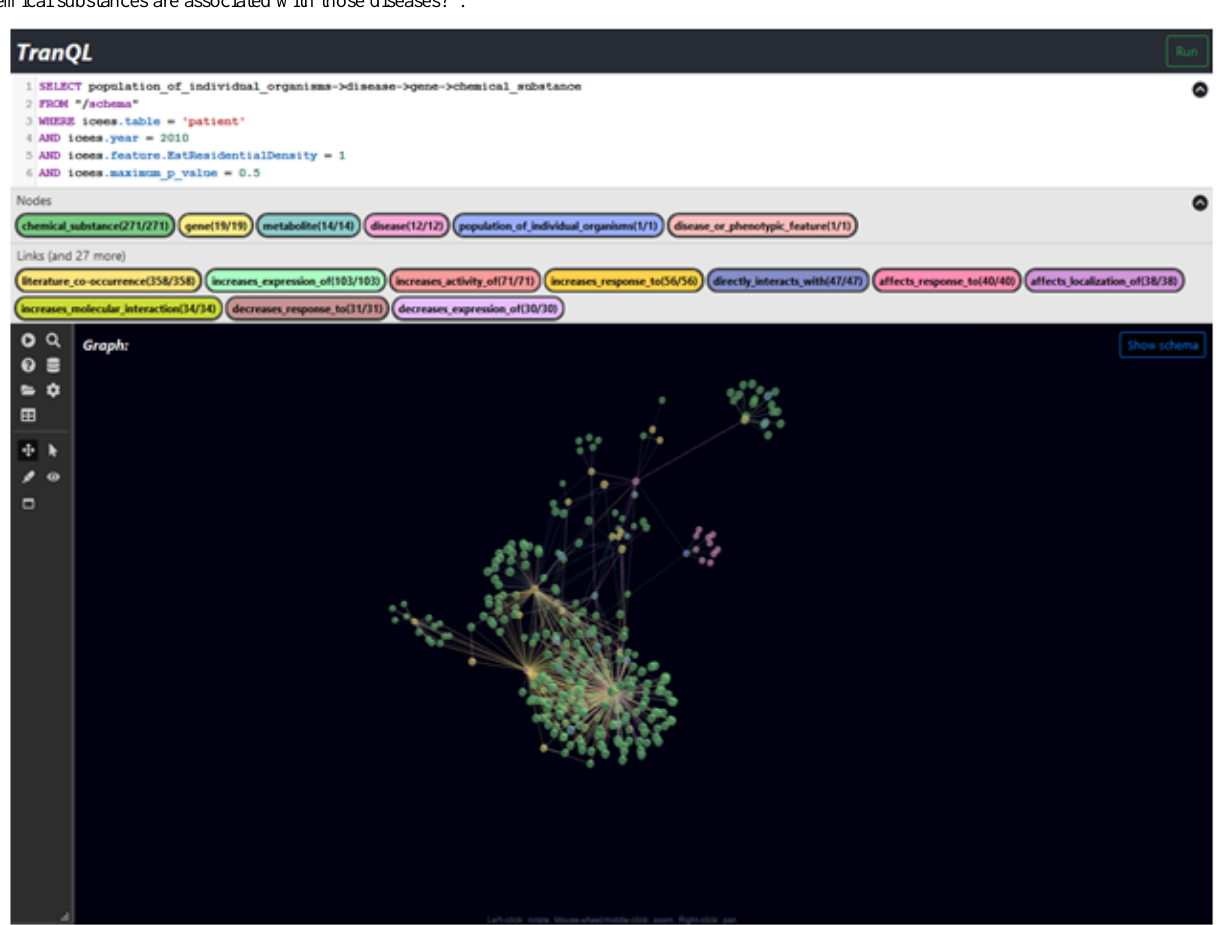
Figure 6. Use Case 2: example TranQL query and resultant KG. The TranQL query was manually translated into the TranQL query language from a natural language query that asked, “What diseases are differentially expressed in patients who live in rural versus urban regions, and what genes and chemical substances are associated with those